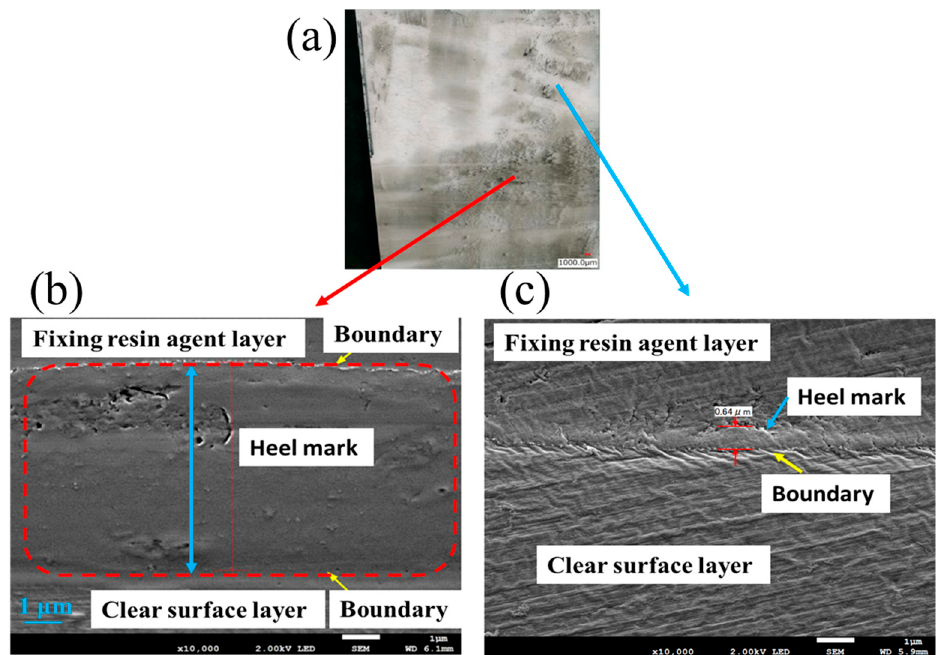
Figure 5. Cross-sectional floor tile SEM results. ( a ) Photographs of the floor surface before and after HM removal. The bottom of the photo show shows the bonded HM, while the top area shows the effects of our surface treatment. ( b ) Cross-sectional photo of the HM on a floor tile ( c ) Cross-sectional photo of tile with the HM removed. The SEM images were taken at magnification of 10,000.